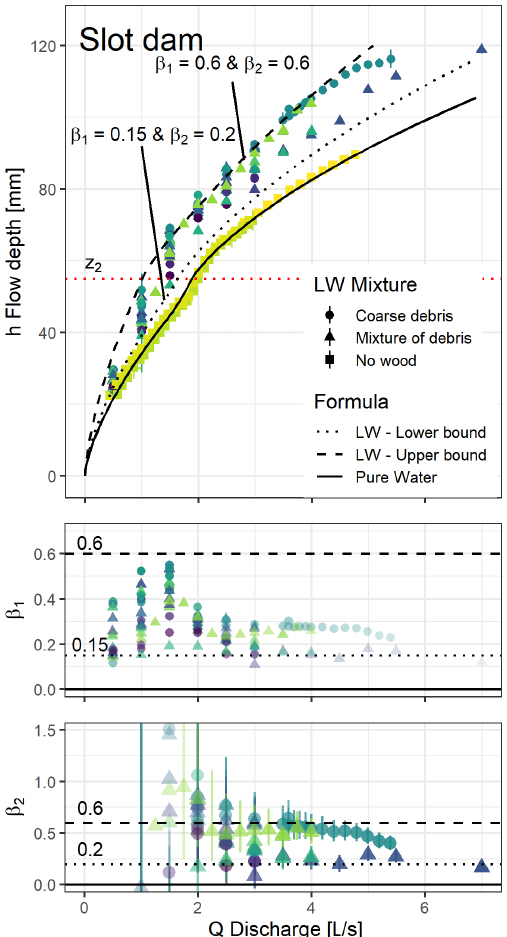
Figure 7. Flow depth versus discharge for grilled slit dam and back- calculated β 1 and β 2 values; each colour shade corresponds to a different run.